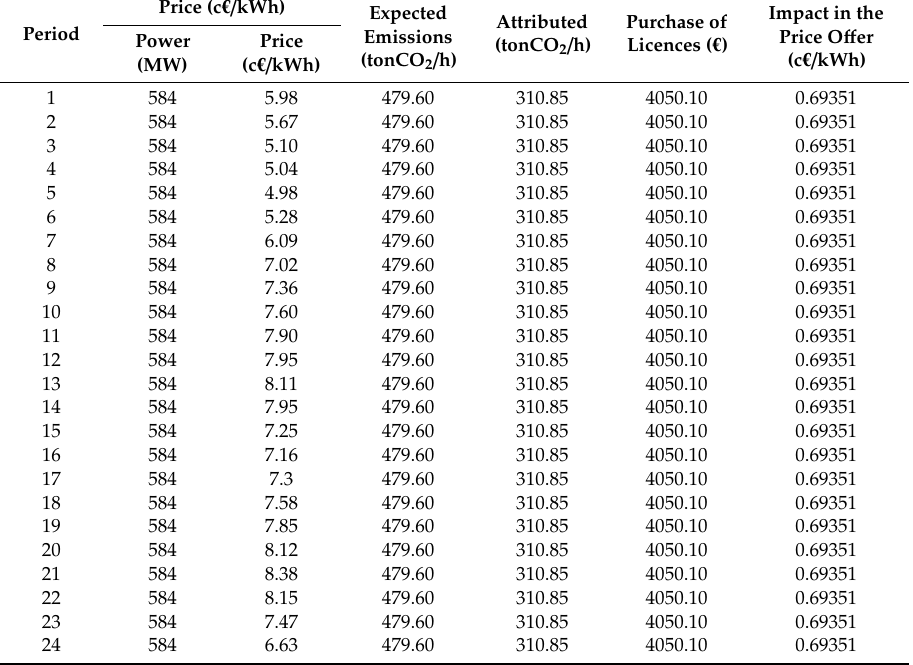
Table 5. Allowances’ influence on energy production